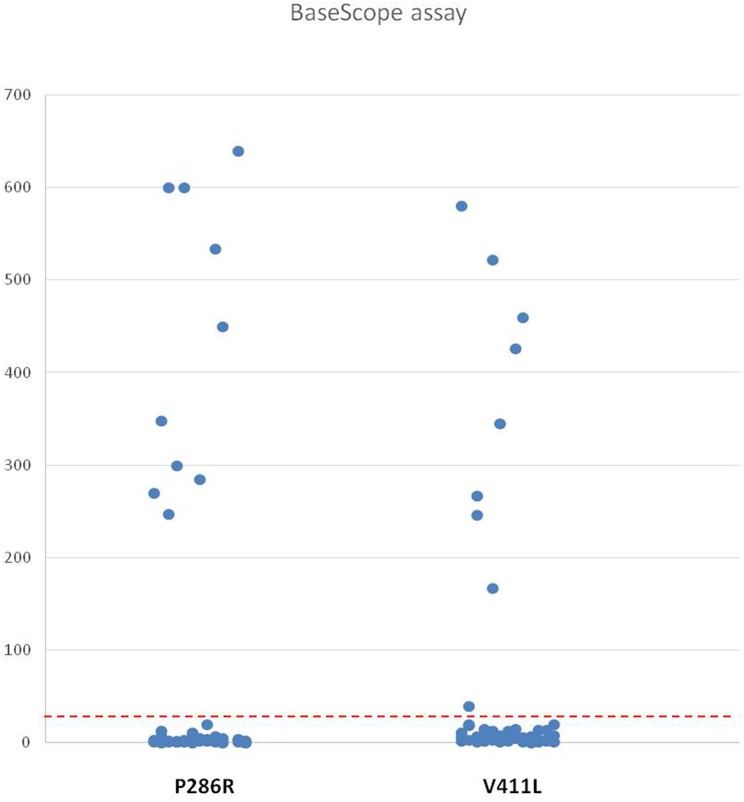
The Number of the Positive Signal of Two Probes in High-Grade EC. The ordinate shows the value of the positive signal of P286R and V411L probes in high-grade EC microarrays (51 cases), and the red dashed line represents the positive threshold (31/3.14 mm2).